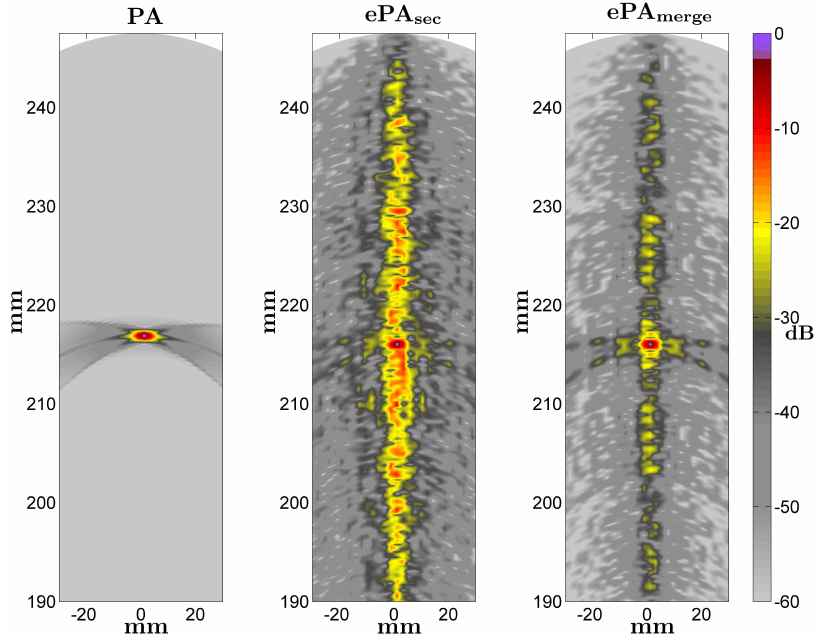
Figure 7. Images obtained with the PA and the proposed ePA techniques. A punctual reflector is located at r = 216 mm and θ = 0 ◦ . An array with N = 96 elements and a Kasami sequences of L = 63 bits are considered in ePA